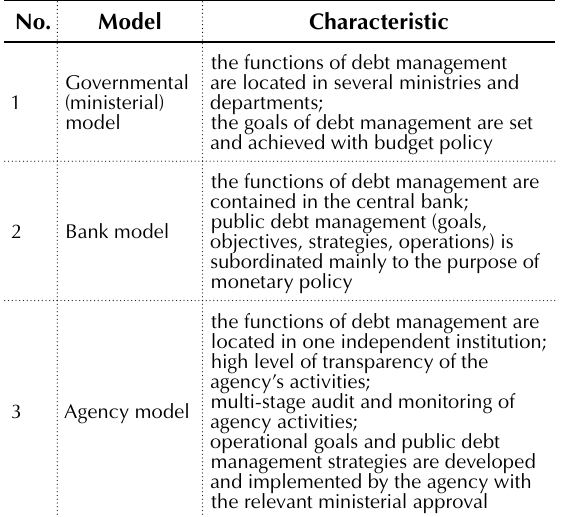
Table 5. Institutional models of the external public debt